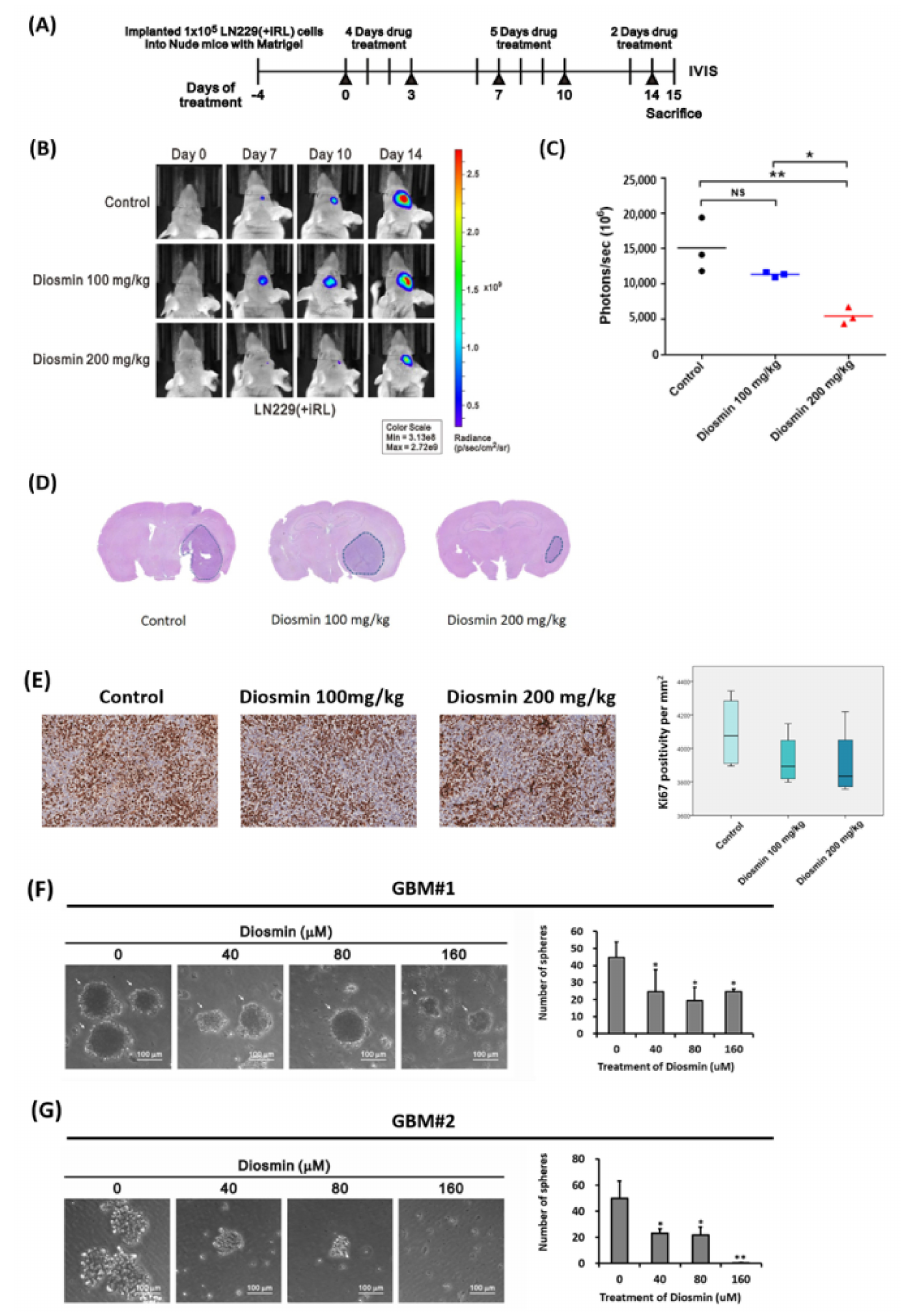
Figure 9. Diosmin inhibits LN229 growth in a mouse orthotopic xenograft model and tumor sphere formation in clinical specimens. ( A ) Experiment timeline for the mouse LN229-iRL orthotopic xenograft model. ( B ) Progression of tumor development estimated from bioluminescence captured with an in vivo imaging system (IVIS). ( C ) Quantitative analyses of in vivo bioluminescent imaging data from the three groups. n = 3 for each group; ns, not significant; * p < 0.05; ** p < 0.01 ( D , E ) Rep- resentative images of H&S ( D ) and Ki67 ( E ) stained brains from representative mice in the three groups. The sections were prepared 15d after intracerebral injection of LN229-iRL cells. Right: Box plots showing the Ki67 positivity per mm 2 (mean ± SEM, n = 3). ( F , G ) Representative photographs of tumor spheres formed from 2 fresh clinical GBM specimens. Scale bar 200 µ m. The cells treated with indicated concentrations of diosmin were cultured in 6-well plates for 8 days for GBM#1 and 14 days for GBM#2. Data are presented as the mean ± s.d. of at least four independent experiments; * p < 0.05, and ** p <